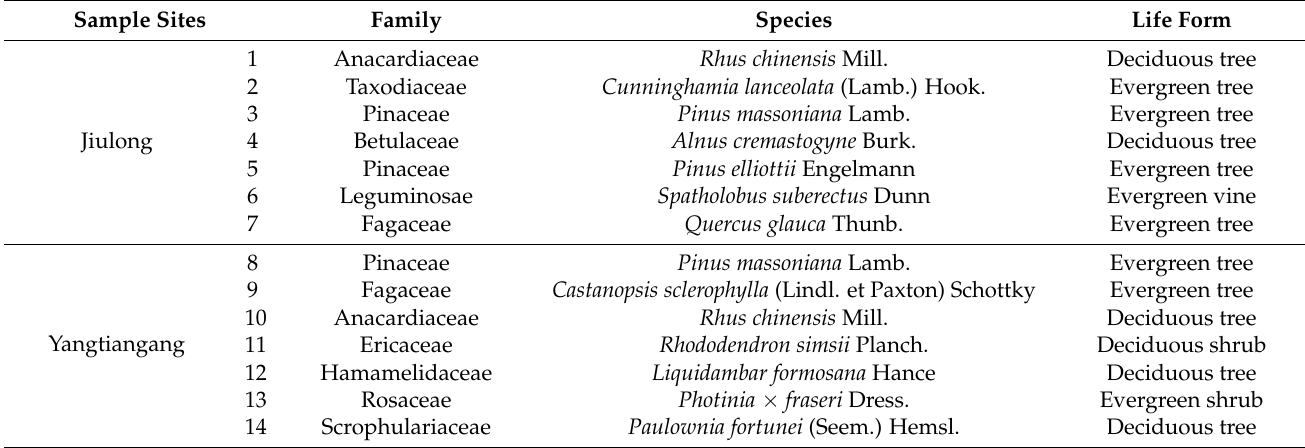
Table 1. List of dominant plant species growing in the study